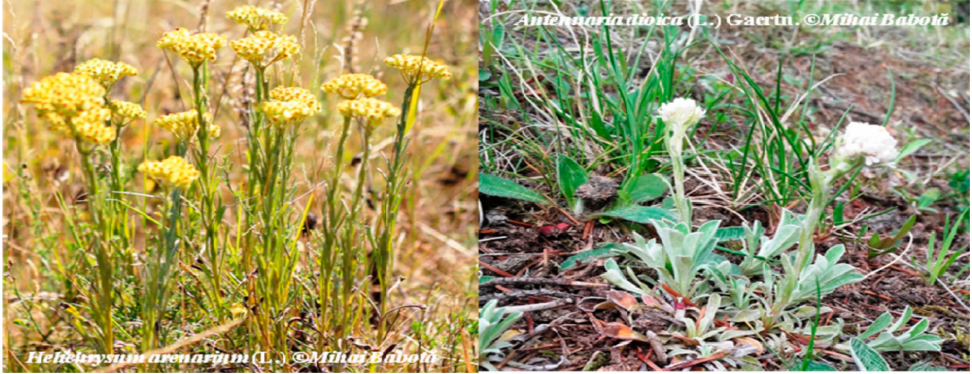
Figure 1. Helichrysum arenarium (L.) and Antennaria dioica (L.)